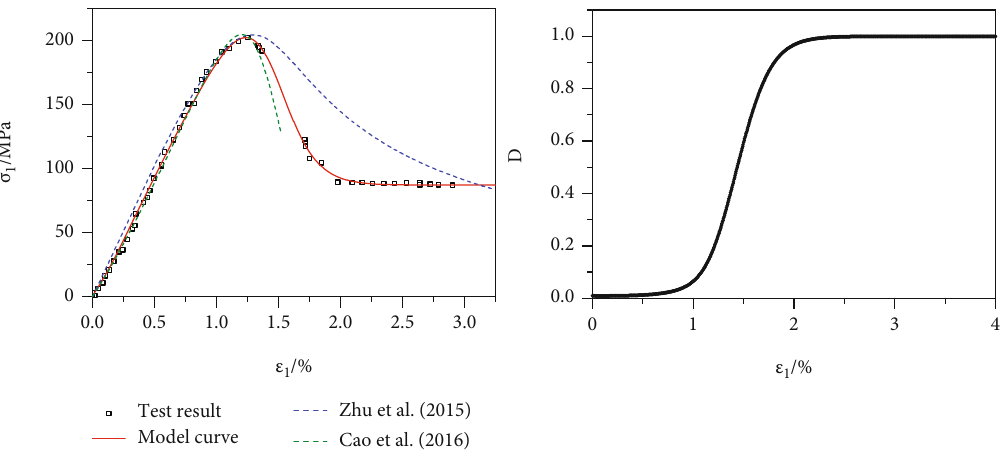
Figure 15: Axial stress-strain curve and damage curve under con fi ning pressure of